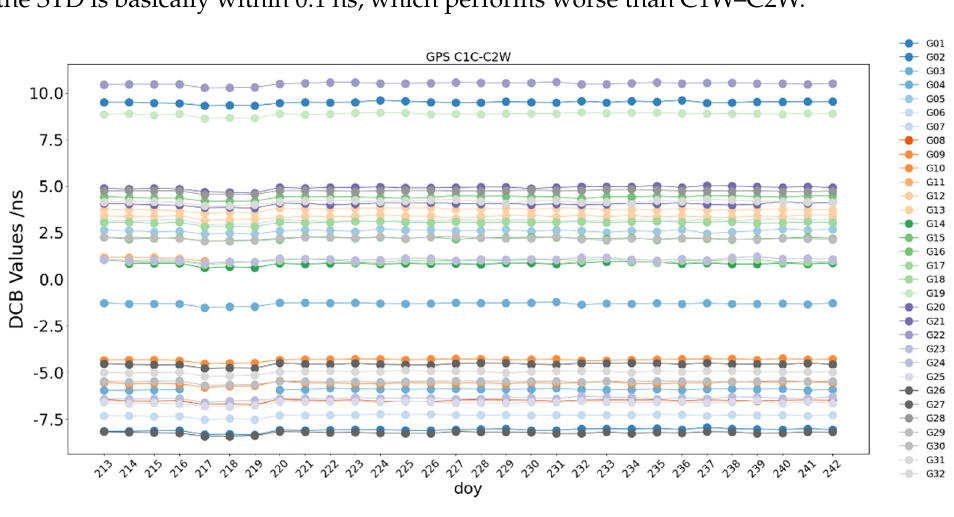
Figure 19. C1C–C2W DCB time series of GPS satellites.